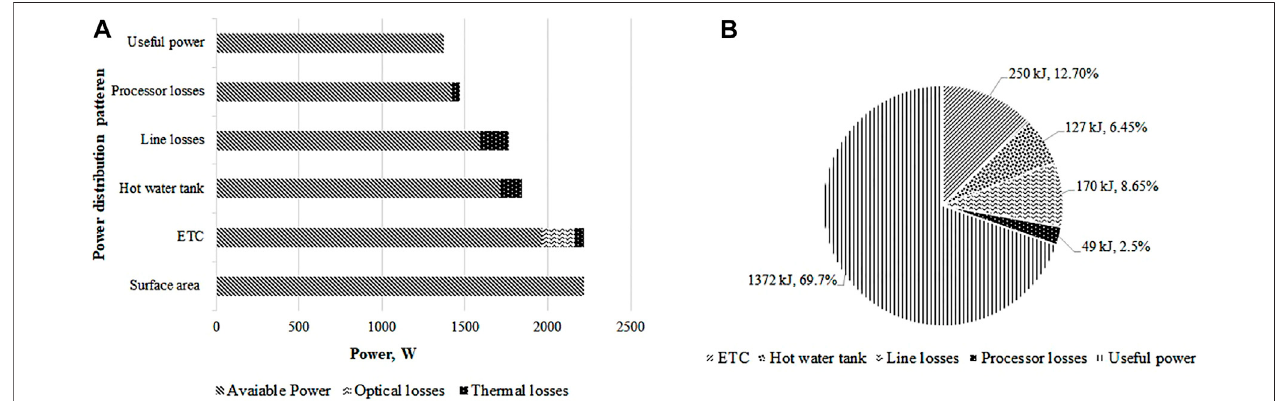
FIGURE 7 | Distribution of various losses and useful energy in terms of power (A) and percentage (B) .